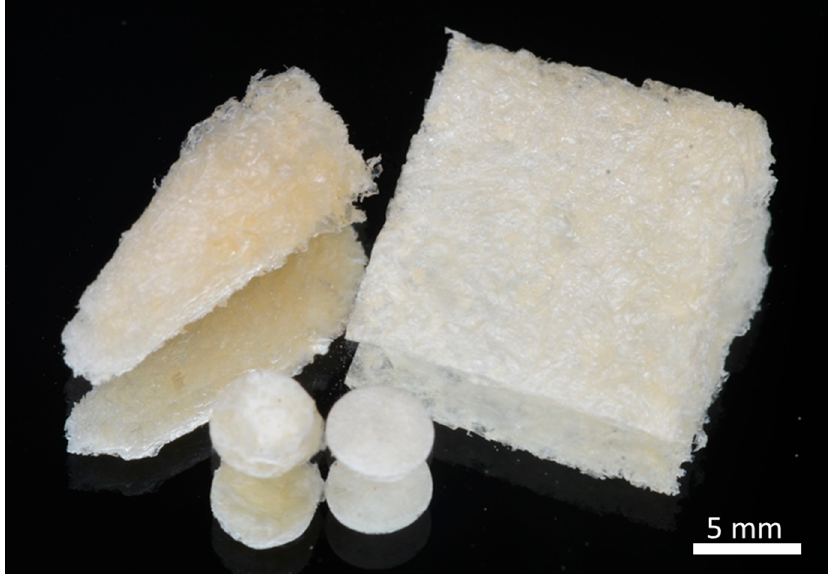
Figure 6. The fabricated CS-DA scaffold after freeze-drying.